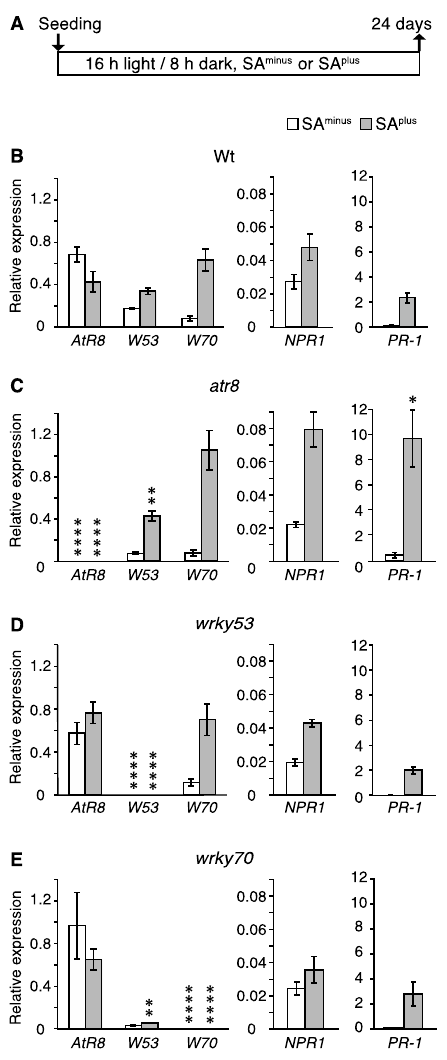
Figure 4. Accumulation levels of RNAs in Arabidopsis under continuous treatment with 20 µ M SA. ( A ) Timeline of experimental procedure. Up arrow indicates sampling. The total RNAs were extracted from the same seedlings shown in Supplemental Figure S2 (24 days after seeding). ( B – E ) The mRNA accumulation levels SA minus or SA plus were compared by RT-qPCR with ACT2 and ACT8 genes as standards. Bar graphs represent mean values of three independent assays ( ≥ 50 plants), and error bars represent ± SE. W53 : WRKY53 , W70 : WRKY70 . Significant di ff erences in RNA accumulation levels between Wt ( B ) and each of the mutants ( C – E ) are indicated as * p < 0.05, ** p < 0.01 and **** p < 0.0001 (Welch’s t -test).